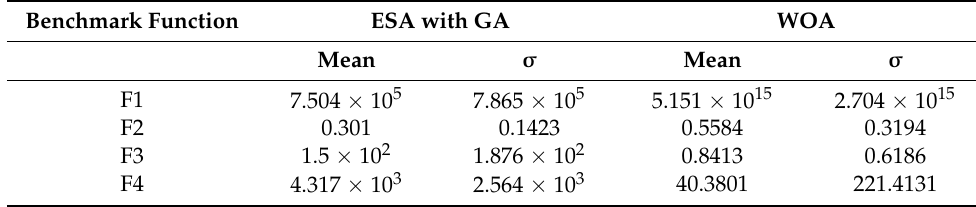
Table 4. Comparisons of Benchmark Functions Results.